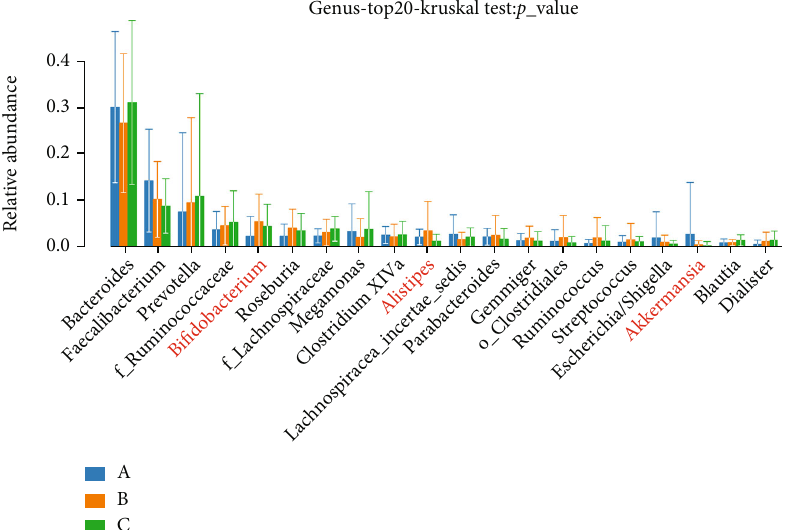
Figure 3: Relative abundance of bacterial genera. The abundance and diversity of the top 20 bacterial genera were compared across groups A, B, and C. Red font indicates signi fi cant di ff erences ( P < 0 : 05